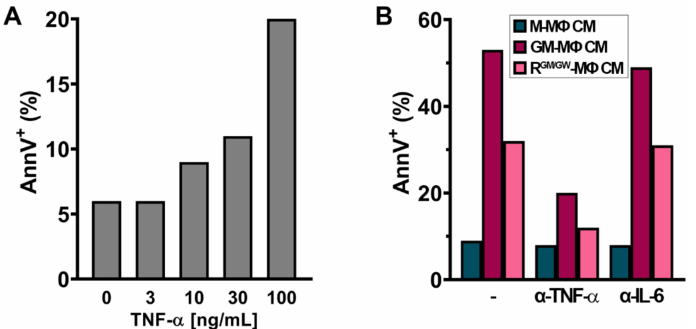
Figure 9. TNF- α in M Φ CM can trigger apoptosis in U937 cells. ( A ) U937 cells were cultured for 24 h with increasing concentrations of TNF- α and apoptosis was monitored by FC. ( B ) U937 cells were cultured for 24 h with 25% indicated M Φ CM and anti-TNF- α (30 µ g/mL) or anti-IL-6 (300 ng/mL) antibodies. AnnV positivity was analyzed by